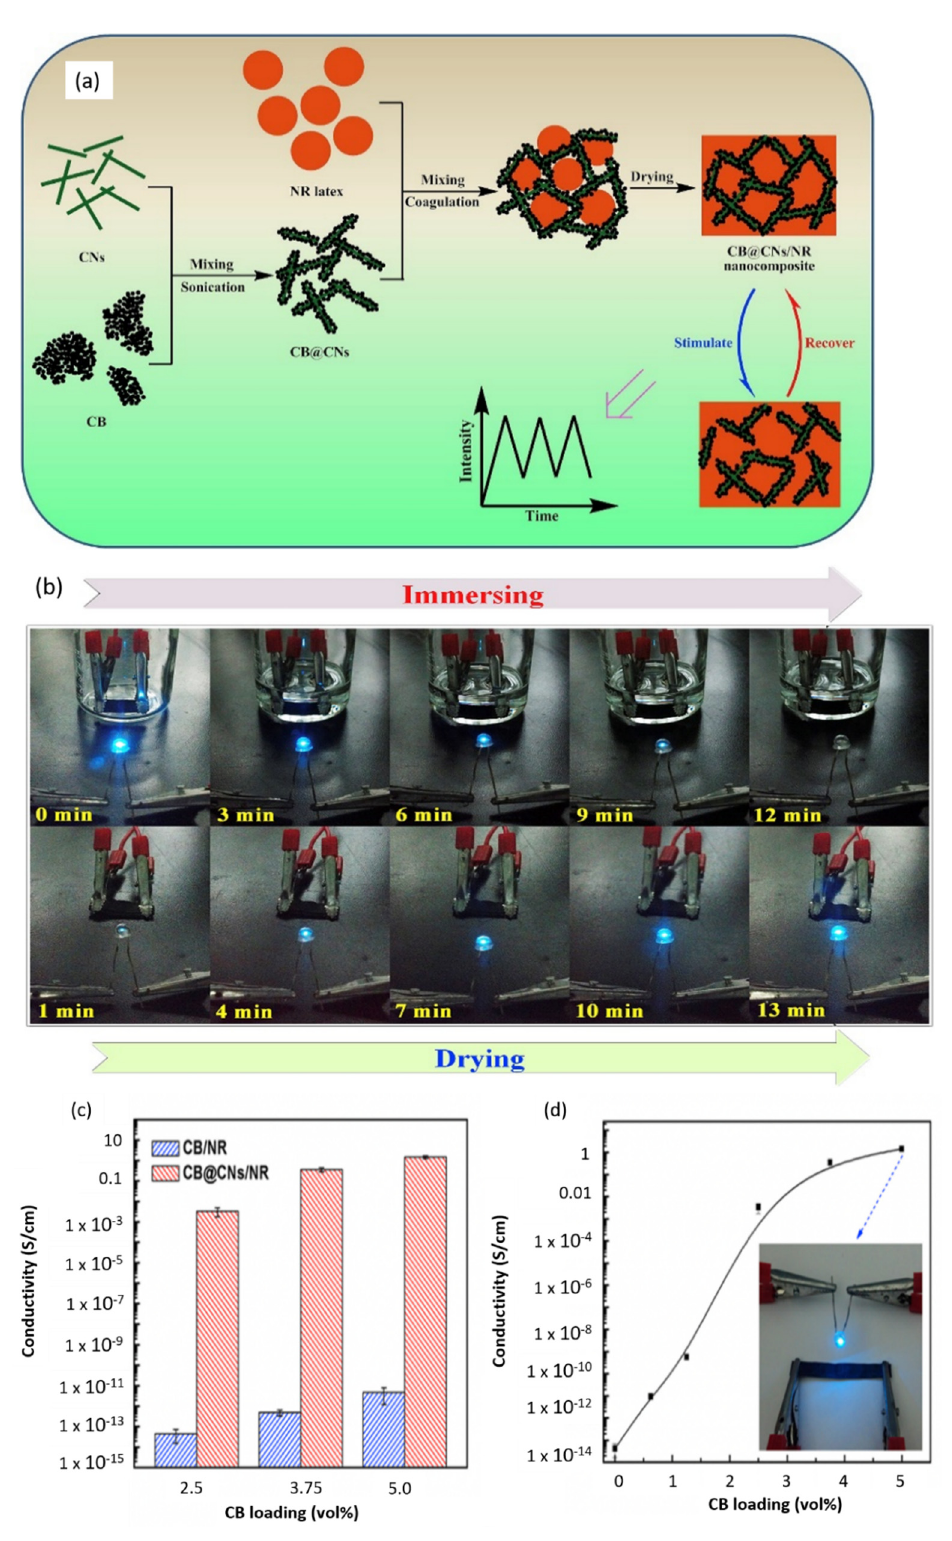
Figure 13. ( a ) Schematic presentation of 3D hierarchical conductive CB/CNC/NR fabrication. ( b ) Images of illumination change during CB/CNC/NR composite (5 vol% CB) immersion into toluene and drying by hot-air. Electrical conductivity responses of CB/CNC/NR and CB/NR with different volume fractions of CB ( c ), electrical conductivity of CB/CNC/NR as a function of CB content (vol%), ( d ) image of CB/CNC/NR lighting up an LED device by 9 V voltage (inset image). Reproduced from Ref. [117].